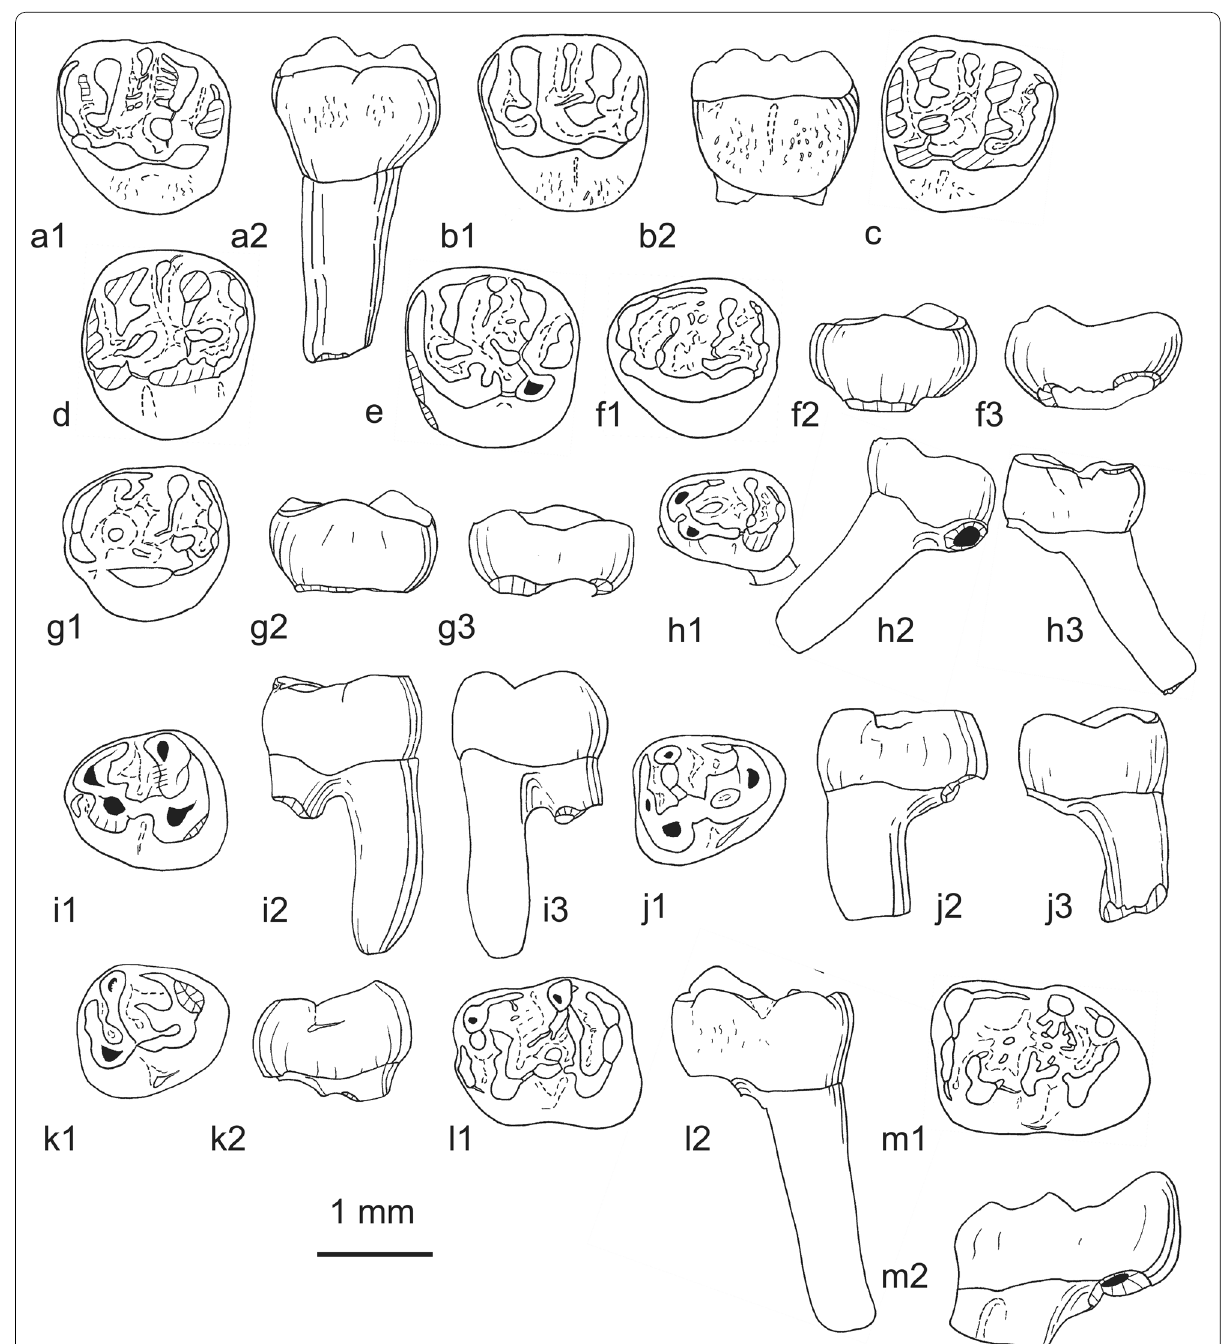
Fig. 39 Teeth of ? Protadelomys cf. alsaticus morphotype 2 from Bouxwiller (Bas‑Rhin). a BUX67‑78, left M2; a1, occlusal view; a2, lingual aspect. b BUX67‑49, left M1; b1, occlusal view; b2, lingual aspect. c: BUX67‑48, right M1; occlusal view. d BUX67‑63, right M1 or M2; occlusal view. e BUX67‑41, left M2; occlusal view. f BUX67‑87, right M3; f1, occlusal view; f2, lingual aspect; f3, buccal aspect. g BUX67‑88 right M3; g1, occlusal view; g2, buccal aspect; g3, lingual aspect. h BUX67‑95, left dp4; h1, occlusal view; h2, lingual aspect; h3, buccal aspect. i BUX67‑106, left p4; i1, occlusal view; i2, buccal aspect; i3, lingual aspect. j: BW56‑54bis, right p4; j1, occlusal view; j2, buccal aspect; j3, lingual aspect. k : BUX67‑98, right p4; k1, occlusal view; k2, buccal aspect. l: BSK‑A27, left m1; l1, occlusal view; l2, buccal aspect. m : BUX68‑37, left m3; m1, occlusal view; m2, lingual aspect. Scale bar 1 =